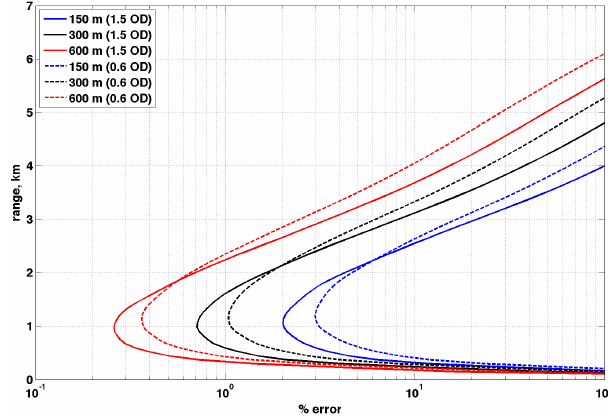
Figure 7. Daytime performance estimate for resolutions of 150m, 300m, and 600m with integration time of 10min and column opti- cal depth at 5km range of 0.6 and